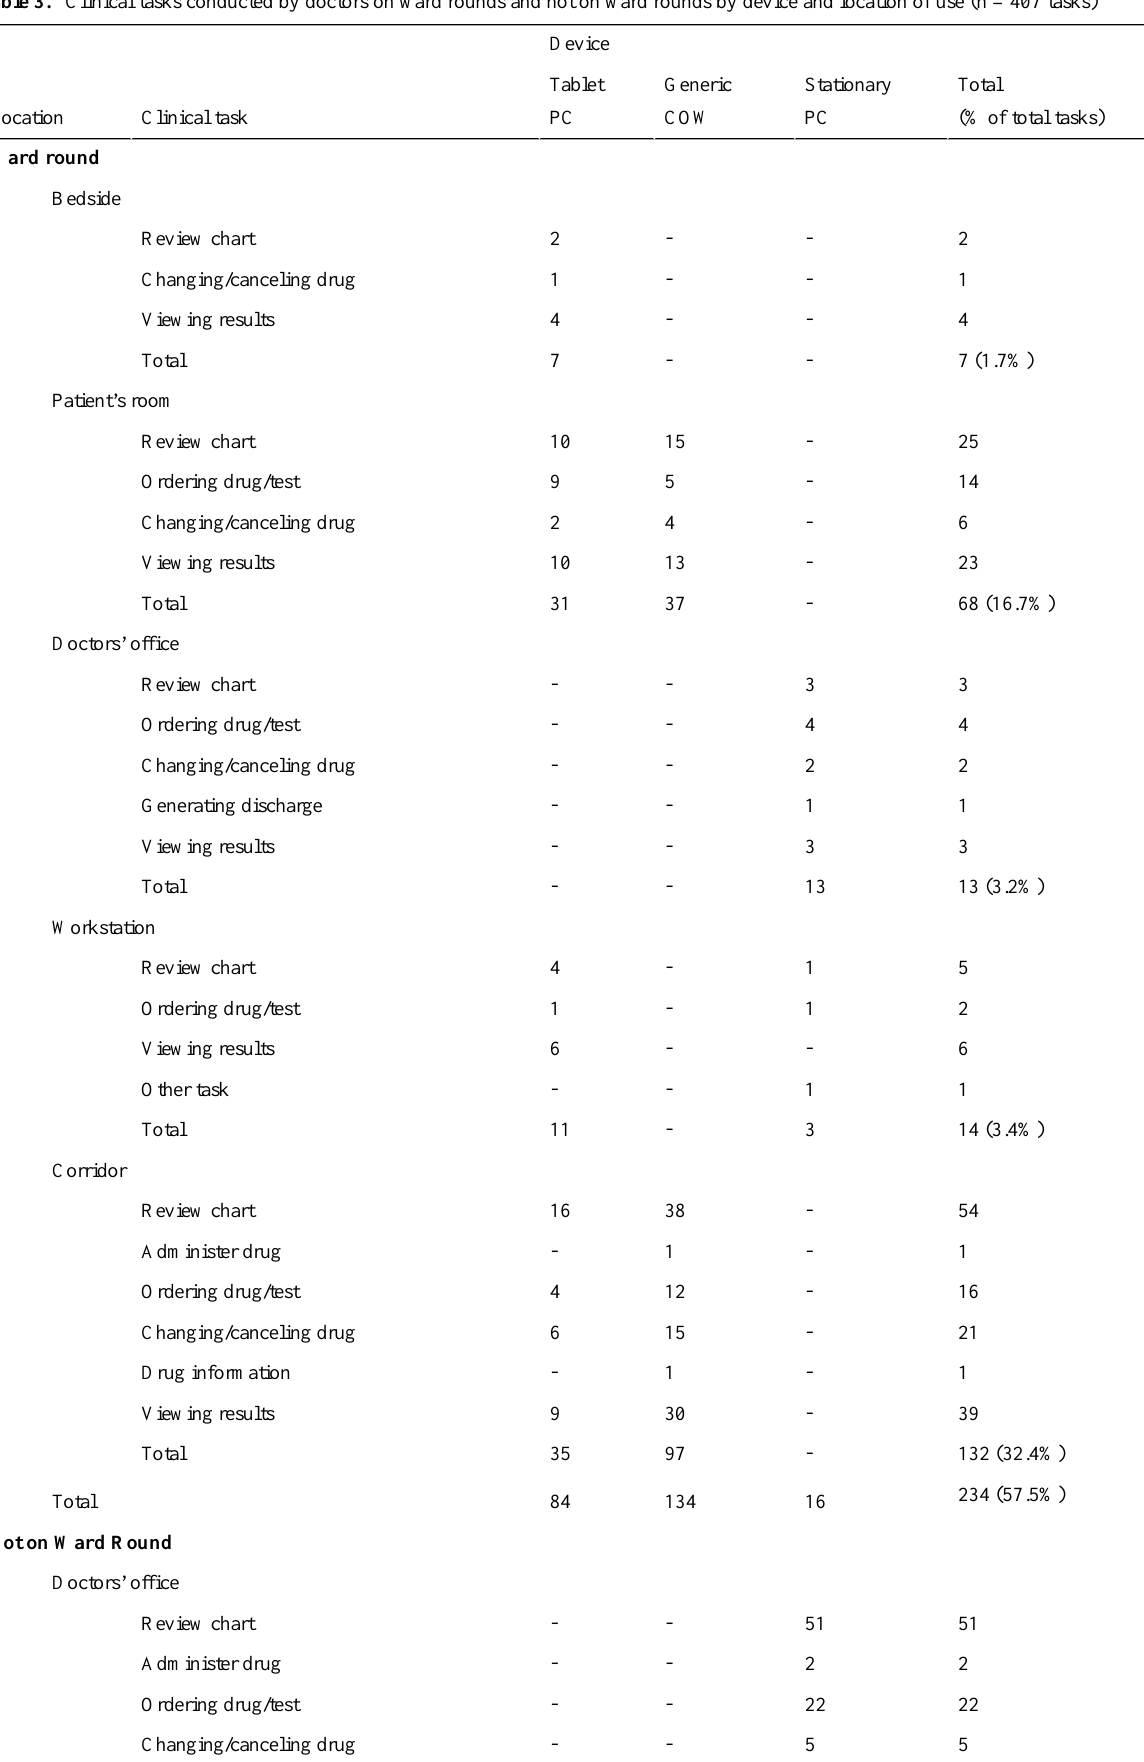
Table 3. Clinical tasks conducted by doctors on ward rounds and not on ward rounds by device and location of use (n = 407